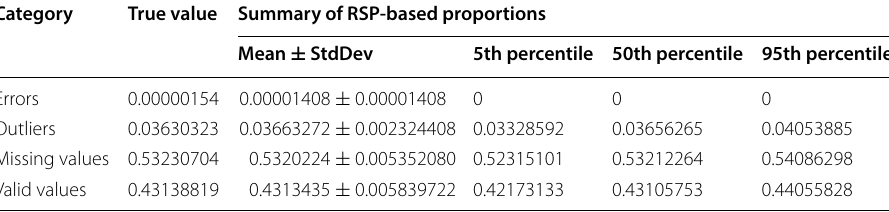
RSP-based proportions were calculated from a sample of RSP blocks ( g = 100